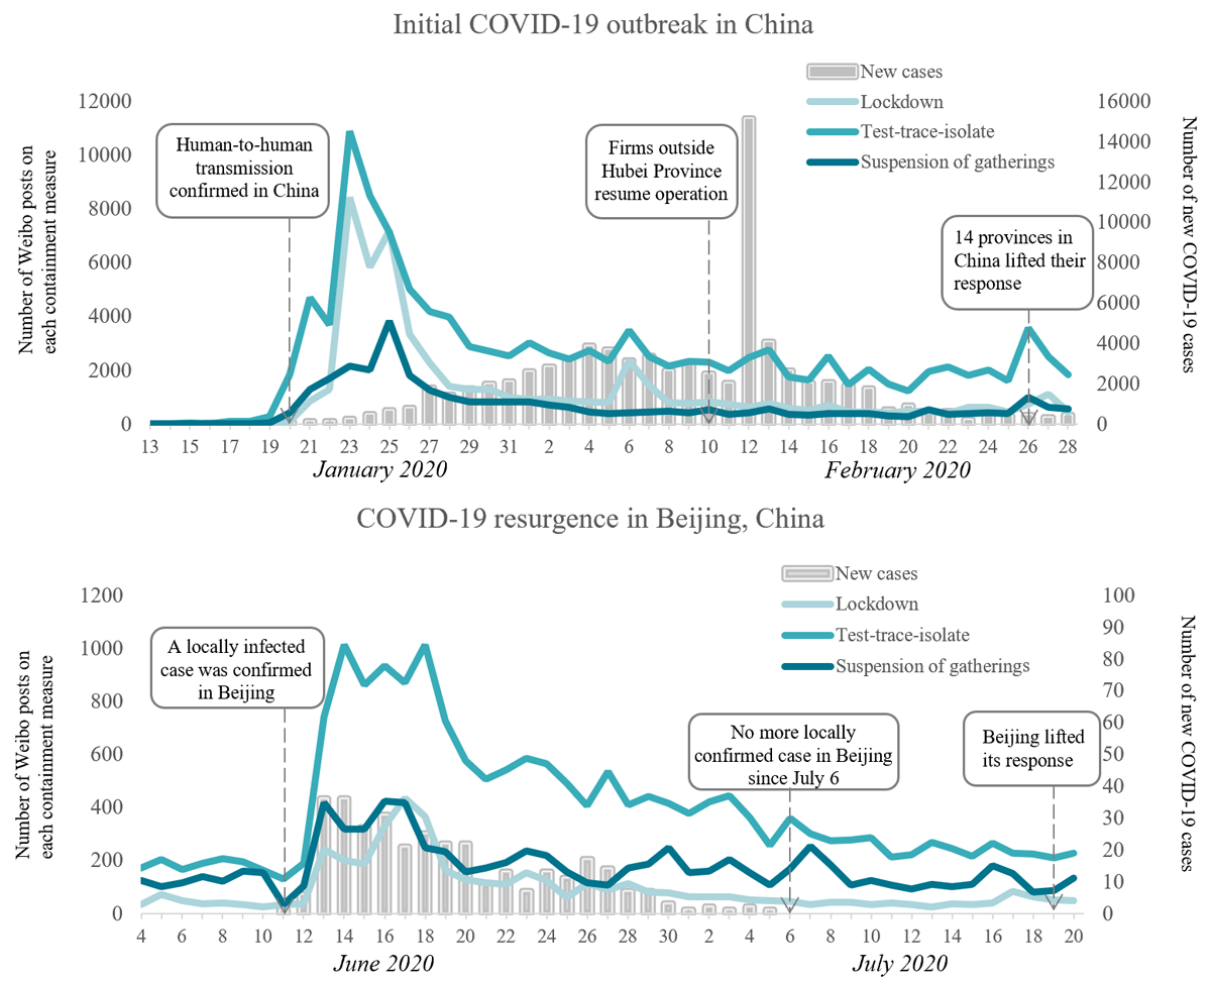
Figure 2. Number of Weibo posts on containment measures and new COVID-19 cases during the initial outbreak and the resurgence of COVID-19 in China. The lines show the daily number of Weibo posts on the lockdown, test-trace-isolate measure, and the suspension of gatherings. The bars show the daily number of new confirmed COVID-19 cases in China and